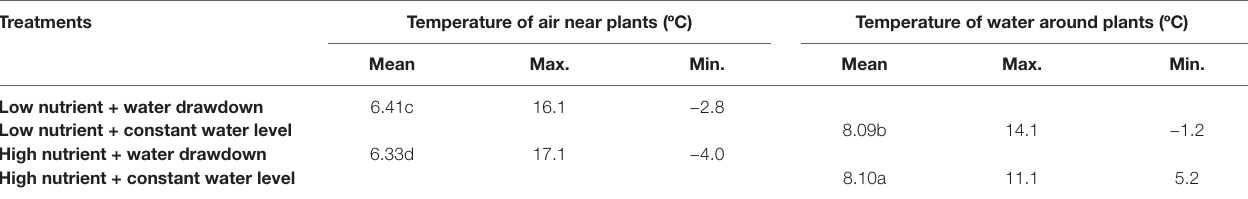
TABLE 1 | Microenvironment temperature in winter. Significant differences among the treatments are indicated by different letters at P < 0.05. Treatments